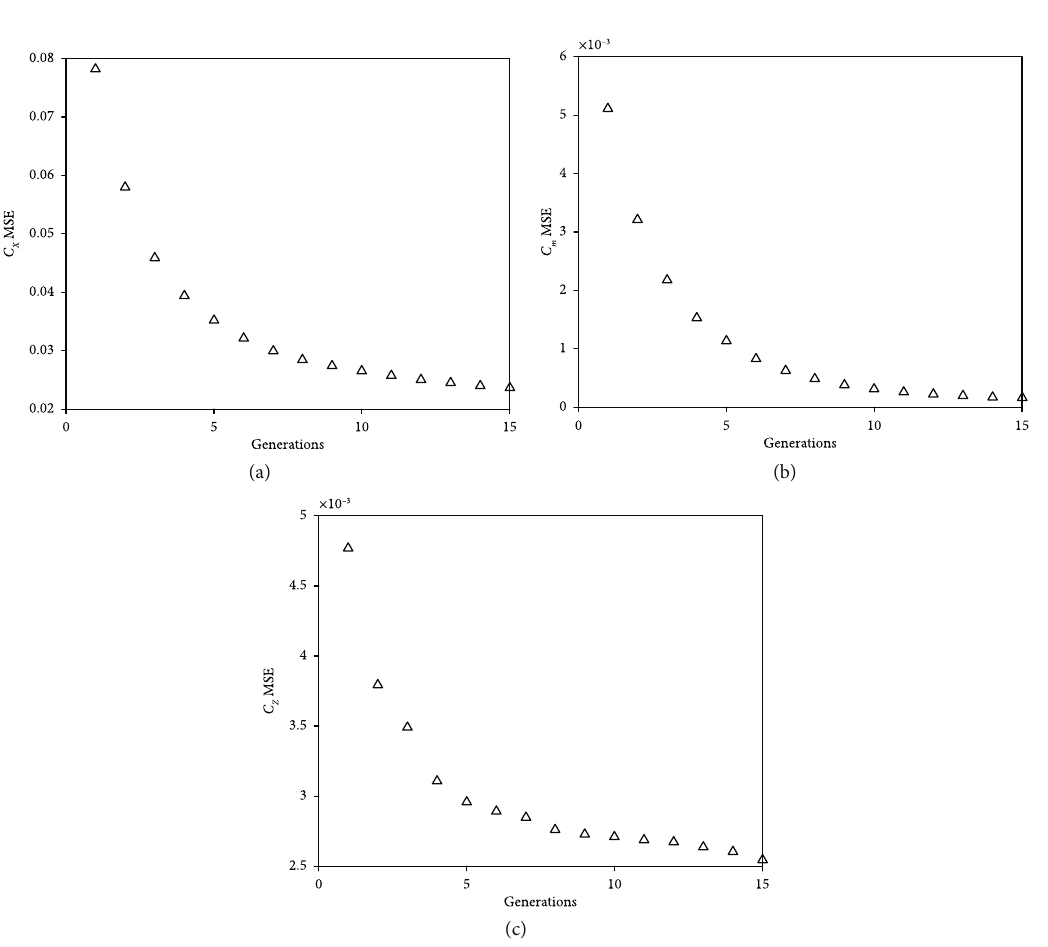
, (b) C , and (c) C X m Z